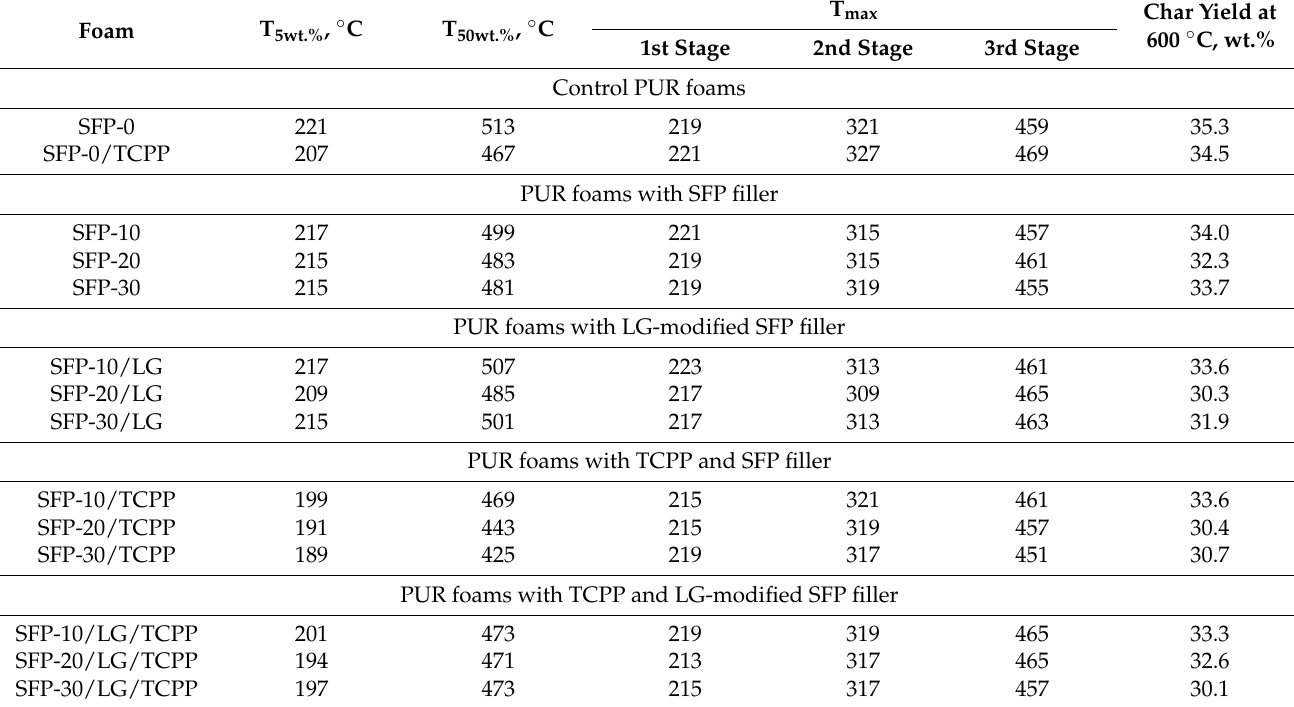
Table 3. Thermal degradation parameters of PUR and flame retardant PUR